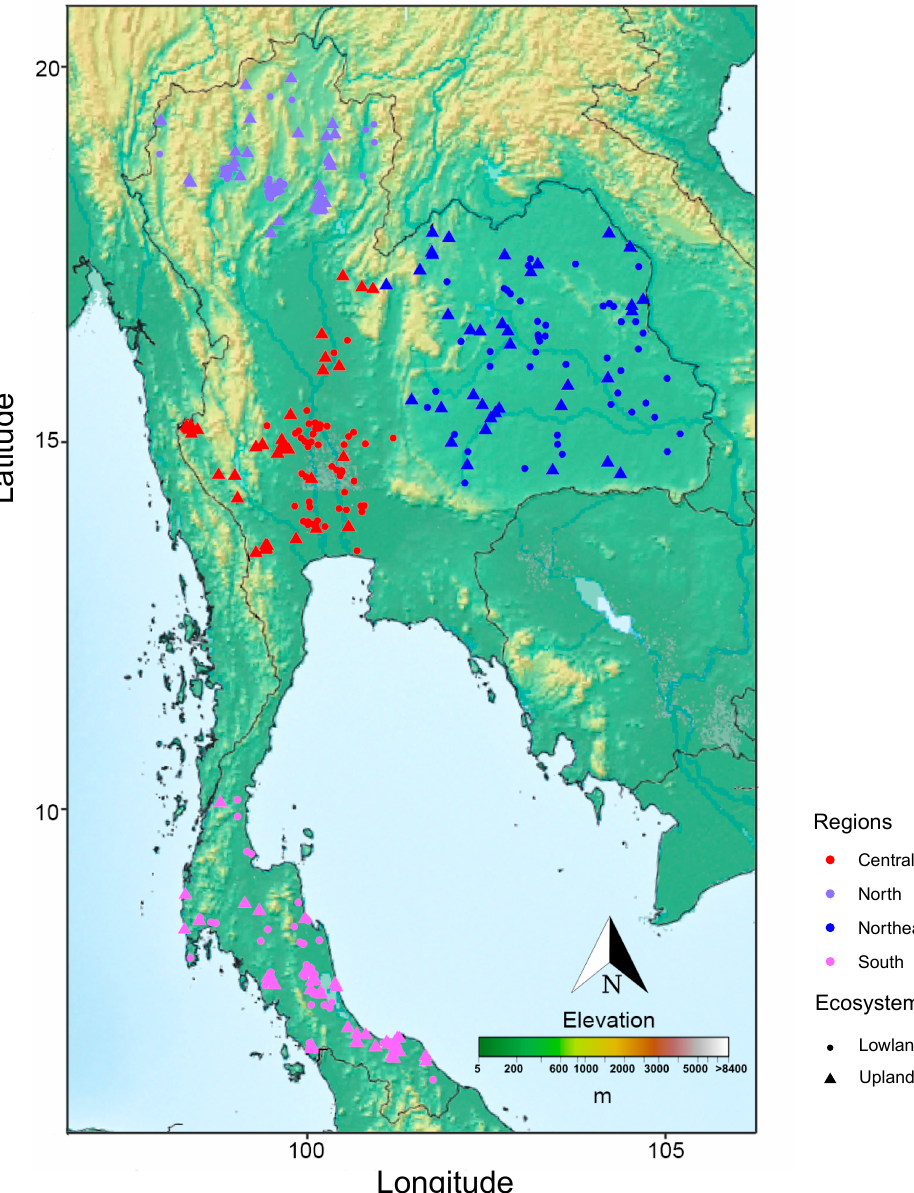
Figure 1. The geographical distribution of the 365 rice landrace accessions across the four geograph- ical regions of Thailand. Different colors represent different populations. Circle shapes represent lowland rice and triangle shapes represent upland rice. Table 1. The polymorphism levels detected using the major allele frequency (MAF), number of different alleles ( Na ), number of effective alleles ( Ne ), observed heterozygosity ( Ho ), expected het- erozygosity ( He ), and Polymorphic Information Content (PIC) based on the SNP markers used in the study.